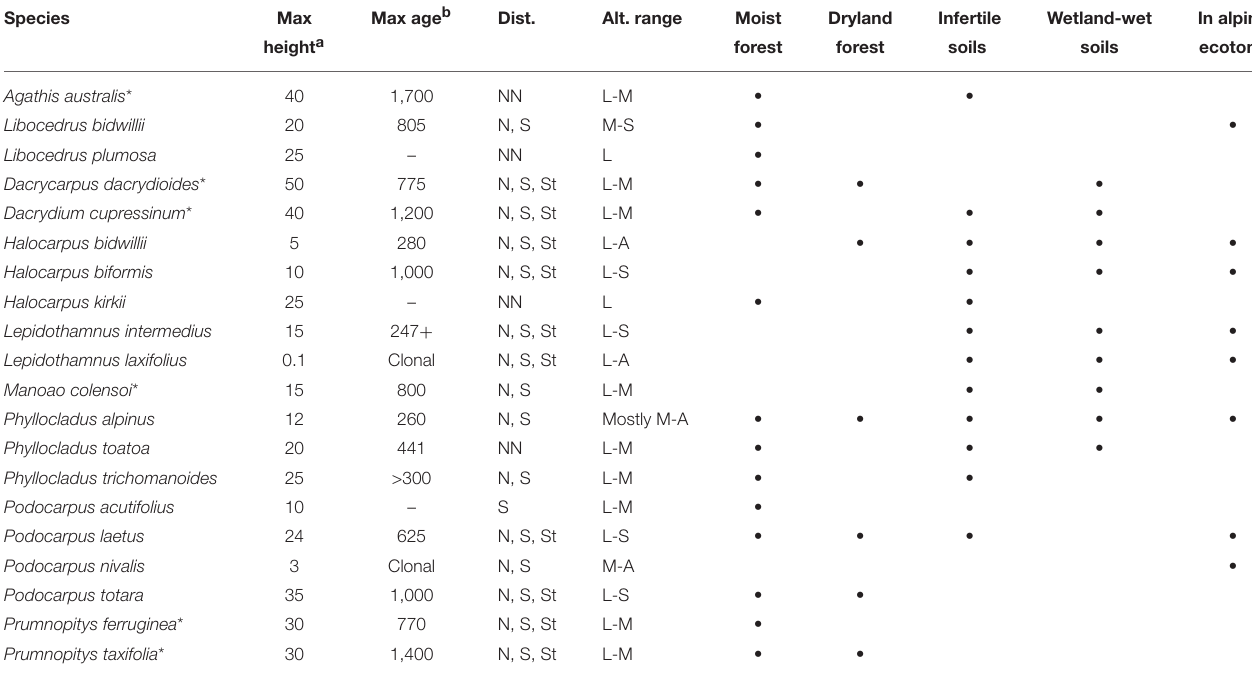
TABLE 1 | New Zealand conifer species: ecological parameters.